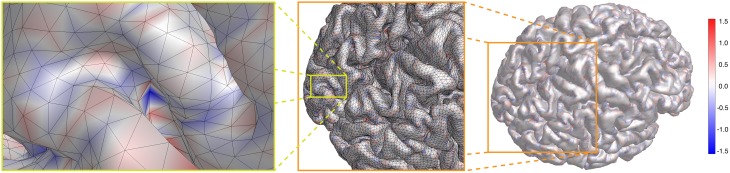
For a cortical surface κgeo≡sign(K)|K| is shown on a color scale [− 1.56/mm, 1.56/mm], as indicated by the color bar. From right to left, the spot with largest negative Gaussian curvature K = − 2.343/mm is brought into focus by zooming closer twice, as indicated by the orange and yellow lines, respectively. It represents a potential nucleation point for SD.